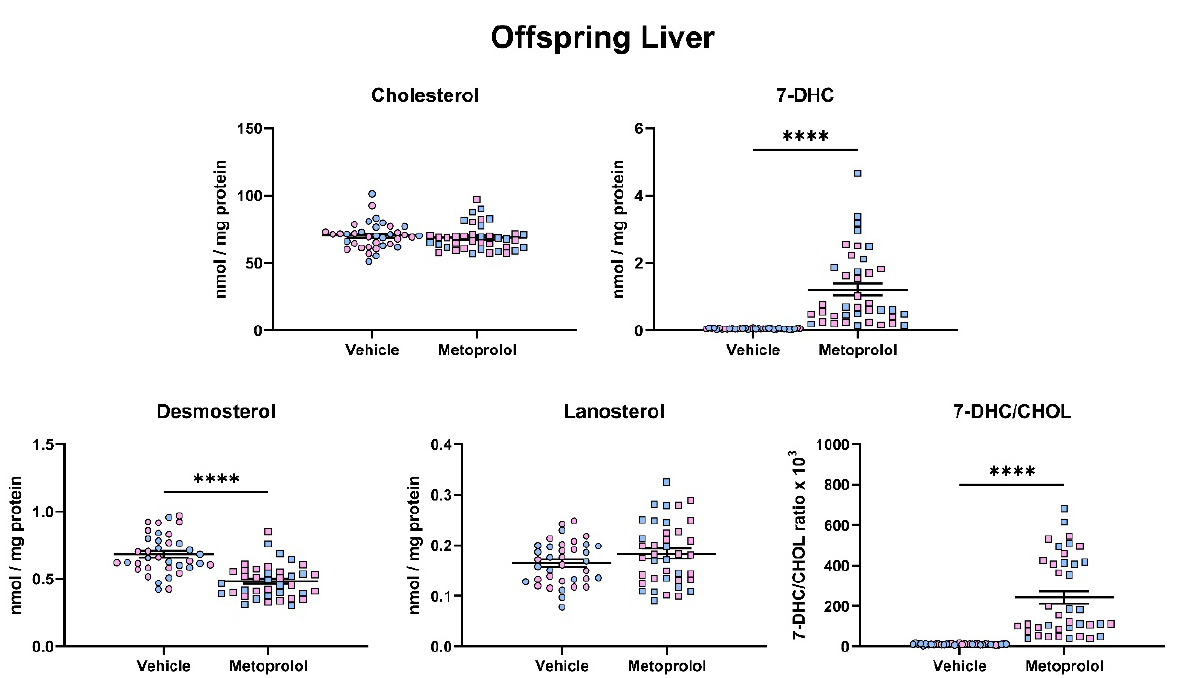
Figure 7. Maternal exposure to metoprolol results in strong elevation of 7-DHC and decreased desmosterol levels in the offspring liver. Pregnant mice were treated with 35 mg/kg MTP from E12 to E19. E19 livers were analyzed for sterol content by LC-MS/MS. Each symbol represents a sample originating from a single offspring liver. Blue fill = male embryos, pink fill = female embryos. Note the strong change in 7-DHC/CHOL (precursor/product) ratio. Statistical significance: **** p < 0.0001.